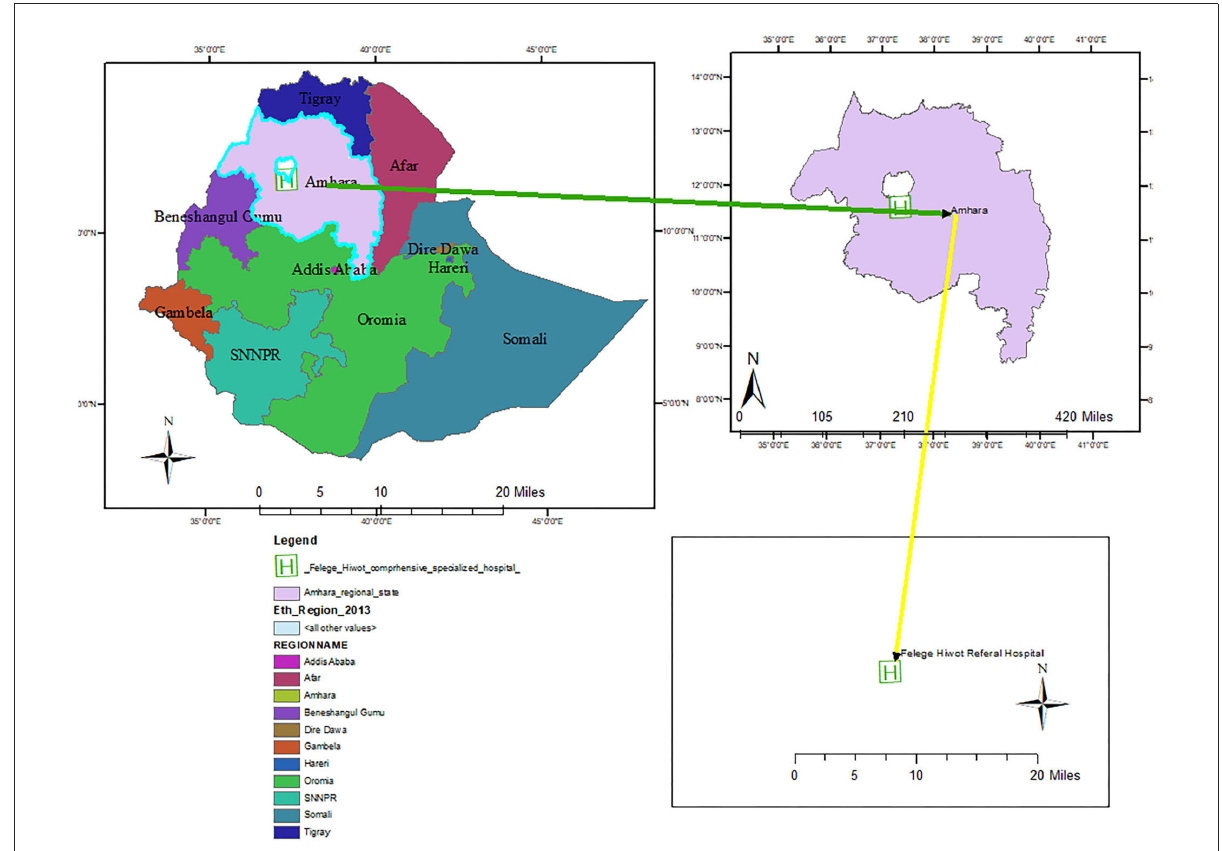
FIGURE1 ArcMap of Felegehiwot Comprehensive Specialized Hospital, Northwest Ethiopia,